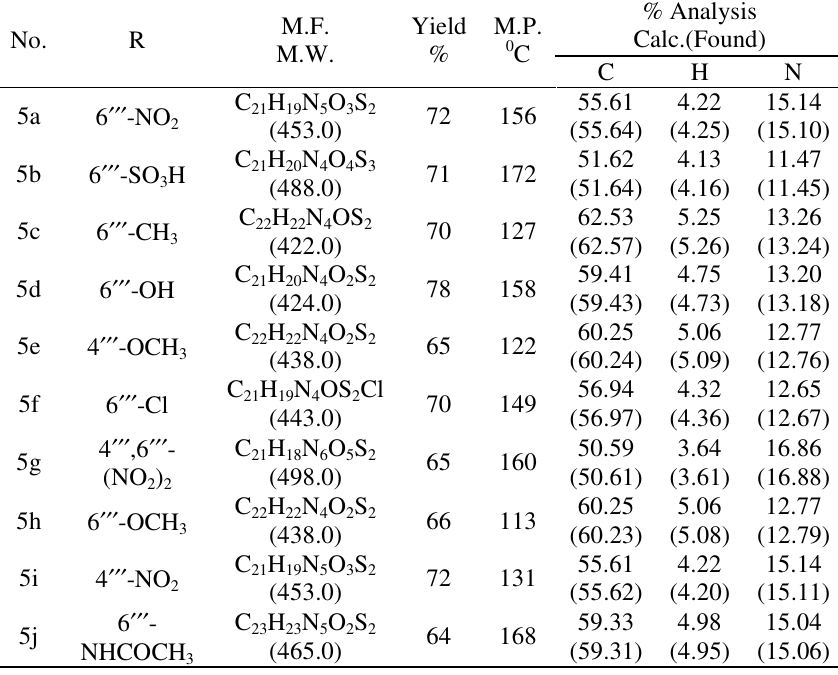
Table 2. Characterization data of compounds